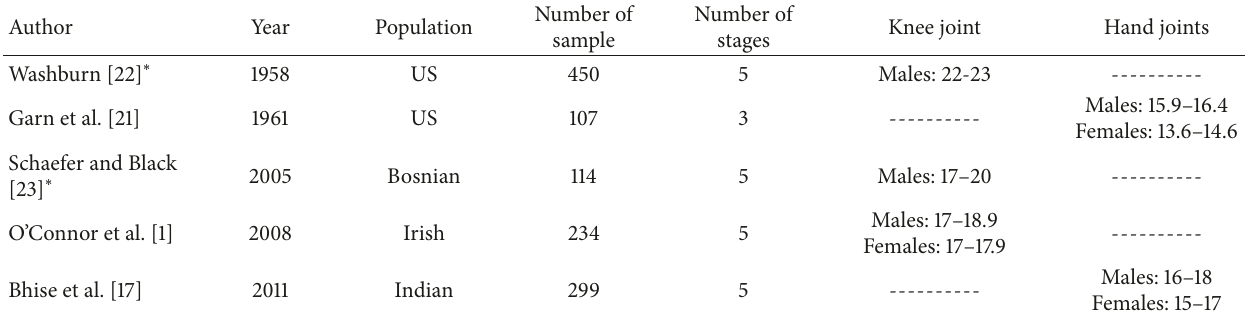
Table 5: Some of the previous studies that were done at the knee and hand